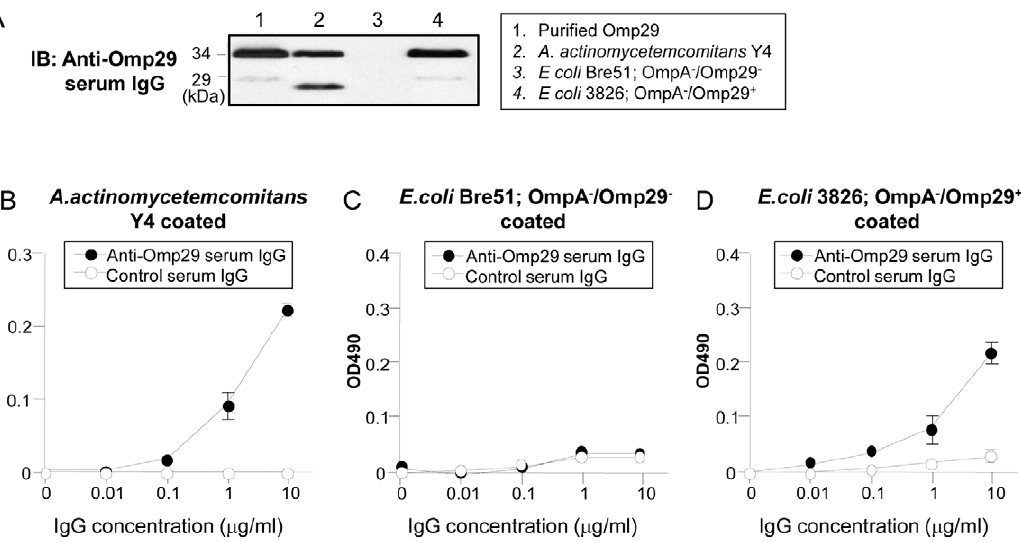
Figure 2. Induction of Omp29 surface expression in OmpA-deficient E.coli . (A) Using Western blot analysis, anti-Omp29 serum IgG was reacted to the purified Omp29, whole Aa Y4, E. coli Bre51 and omp34 gene-transfected E. coli Bre51. The heat-modifiable property of Omp29 resulted in two distinct migration patterns at 29 kD and 34 kD. (B–D) The formalin-fixed whole Aa Y4 (B), formalin-fixed whole E. coli Bre51 (C) or E. coli 3826 (D) was reacted with anti-Omp29-specific IgG and control serum IgG at various concentrations as indicated on the x-axis. The antibody binding to each fixed bacterial antigen was detected with goat anti-mouse IgG-biotin ( 6 10,000), followed by HRP-conjugated avidin ( 6 40,000). Colorimetric reactions were developed with o-Phenylenediamine in appropriate buffer. The optical density (OD) of each well of ELISA plate was measured at 490 nm. The results are expressed as mean OD 6 SD of triplicate wells.